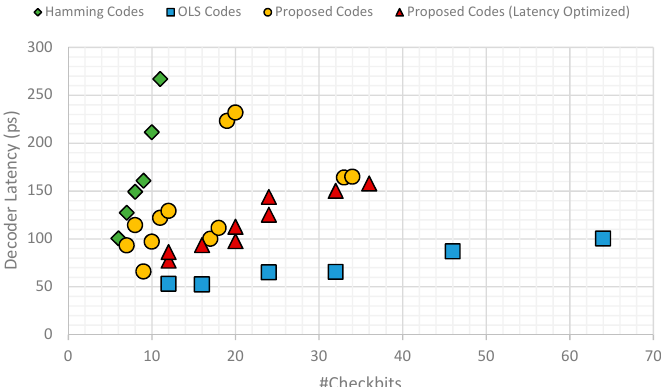
Figure 11. Comparison of memory overhead and decoder latency for the different codes across different number of data bits.